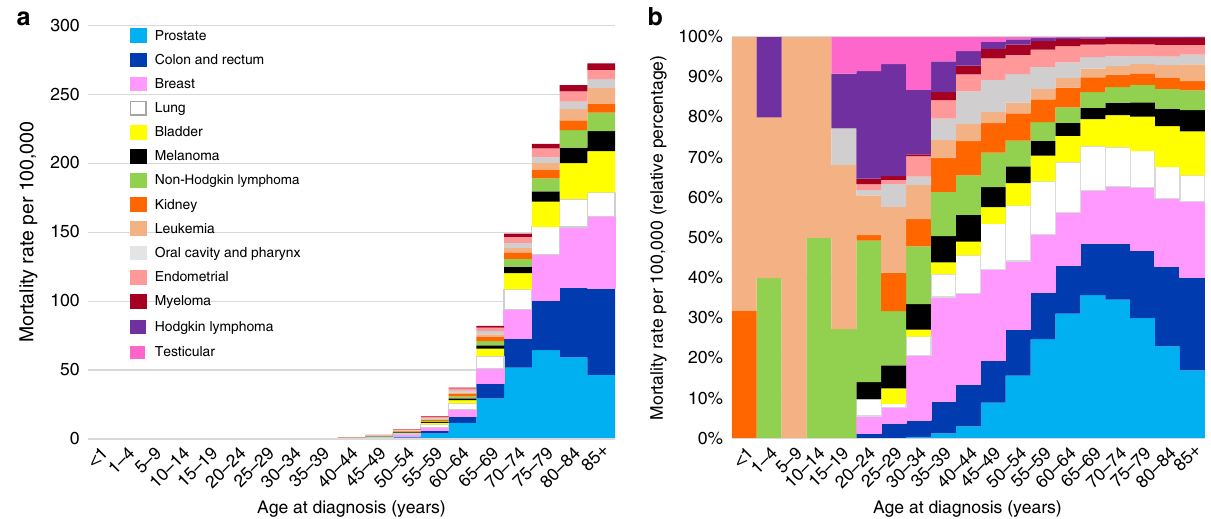
Fig. 2 Age adjusted mortality rates per 100,000 for fatal heart disease by cancer subsite. a The y -axis depicts the heart disease-speci fi c mortality rate per 100,000 and the x-axis depicts the age group at diagnosis in years. The colors depict the disease sites as follows: light blue = prostate; dark blue